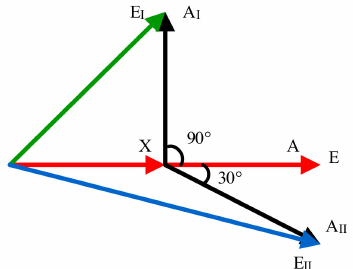
Figure 16. The single-phase vectordiagram of synthetic electromotive force (1/4 model).